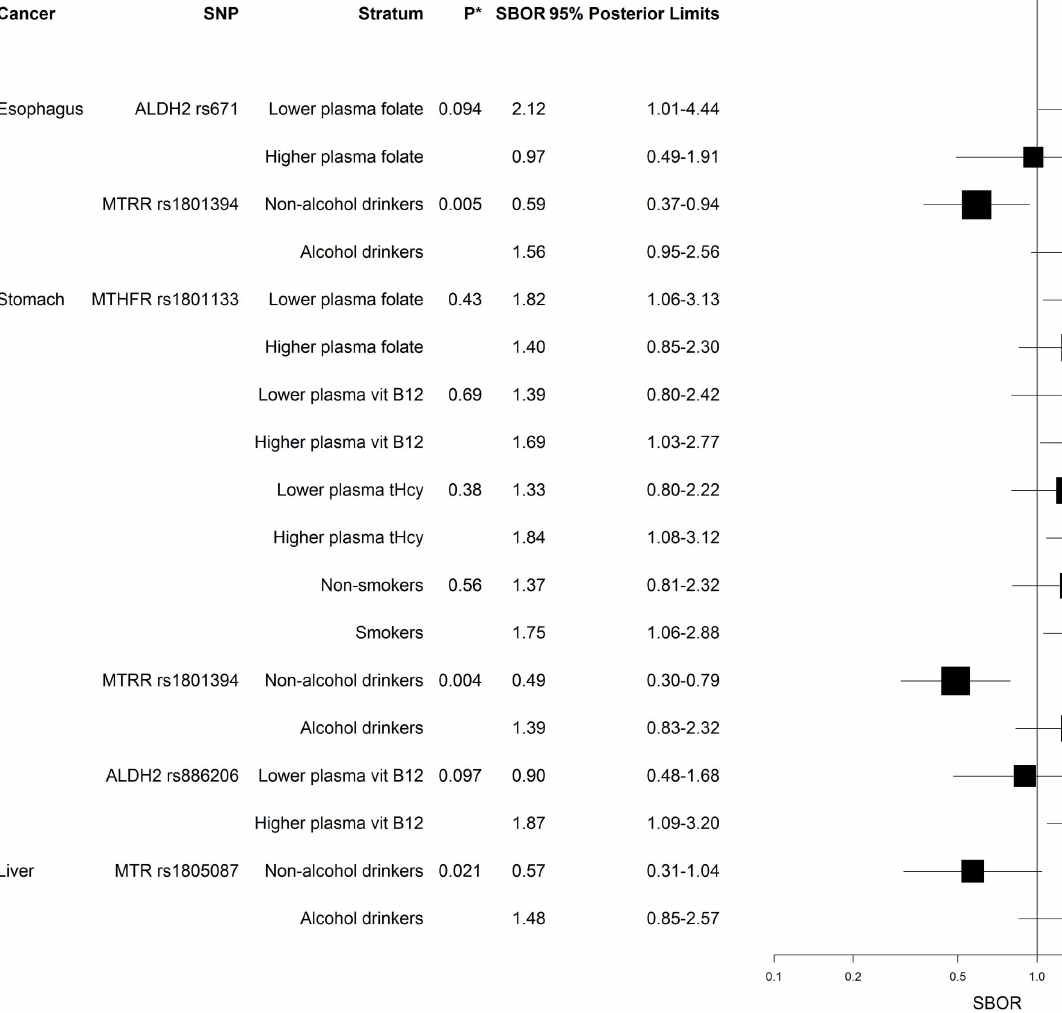
Figure 1. Selected semi-Bayes stratum-specific associations. Selected semi-Bayes stratum-specific associations between SNPs in MTHFR , MTR , MTRR , DNMT1 , ALDH2 , and upper GI cancer susceptibility, by plasma levels of micronutrients (folate, vitamin B12, and homocysteine) and environmental factors (smoking, alcohol drinking, H. pylori CagA status, HBsAg status, and plasma AFB1-albumin adduct levels). Semi-Bayes adjusted ORs (SBOR) and 95% posterior limits were under dominant genetic models, except for the SBOR relating ALDH2 rs671to esophageal cancer, where recessive genetic model was used. P * denotes P -value for homogeneity test.